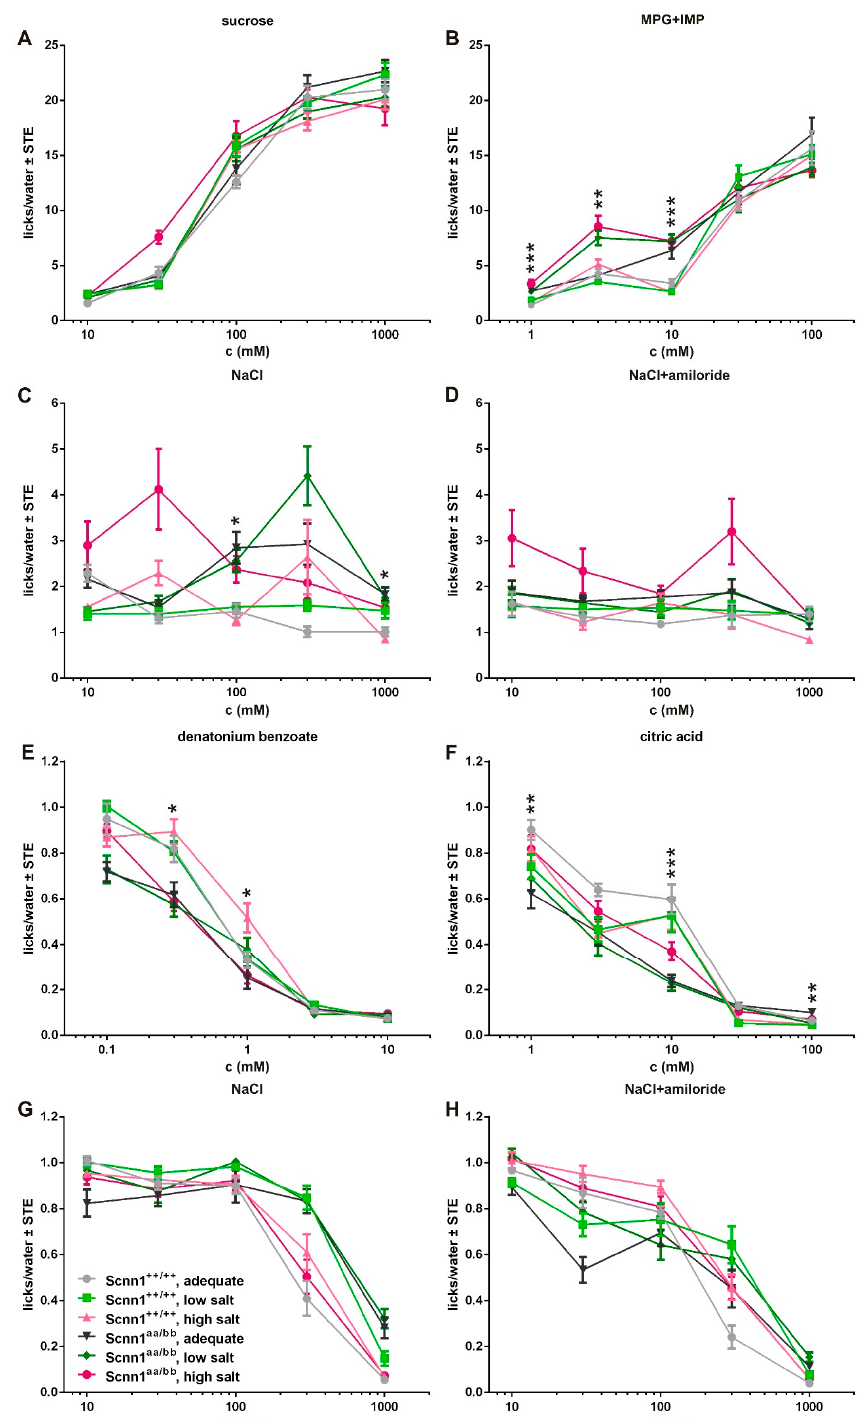
Figure 3. Taste response curves of Scnn1 ++/++ and Scnn1 aa / bb mice after dietary intervention. After 4 weeks fed with sodium-adequate, low, or high salt diet, Scnn1 ++/++ and Scnn1 aa / bb mice were subjected to short-term preference tests using an automated gustometer. To do so, animals were either restricted for 22.5 h with access to 2.0 mL water and 1 g food (attractive restriction conditions, ( A – D )) or water-deprived for 22.5 h (aversive restriction conditions, ( E – H )). Taste solutions and concentrations were presented randomly. Each data point represents a mean ± standard error (SE) of 5 s presentations from the 10 to 11 animals tested. Statistical testing was based on UNIANOVA and post-hoc analysis using Bonferroni´s multiple comparison test. Significant di ff erences over all groups in line drawings were indicated by asterisk(s) with * p < 0.05, ** p < 0.01, and *** p <